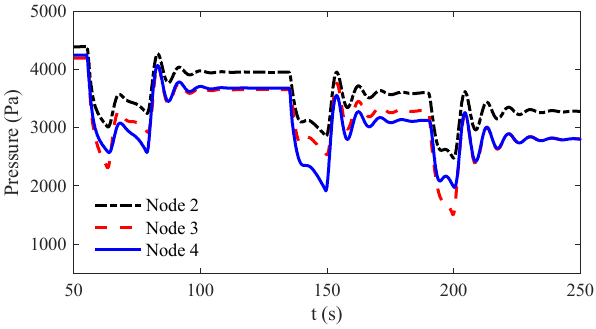
Figure 12. Gas pressure variations during the mode switching process.